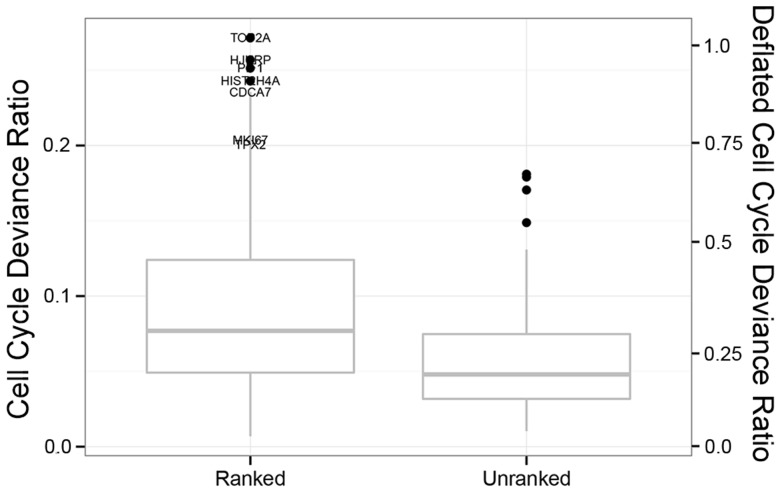
Box and whiskers plot of cell cycle deviance ratio in ranked and unranked genes.The proportion of stochastic variability in the Hurdle Model explained by cell cycle is shown on the primary y-axis (left) for ranked and unranked genes, with box giving the 25th, 50th and 75th percentiles, and whiskers showing 1.5 times the inter-quartile range. The deflated scale on the secondary y-axis (right) shows the deviance as a percentage of the most completely explained gene (TOP2A, 27%) and is intended as an upper bound for the amount of remaining biological deviance in non-cell-cycle genes. Under this conservative rescaling, cell cycle explains only 25% of the deviance in 75% of unranked genes.